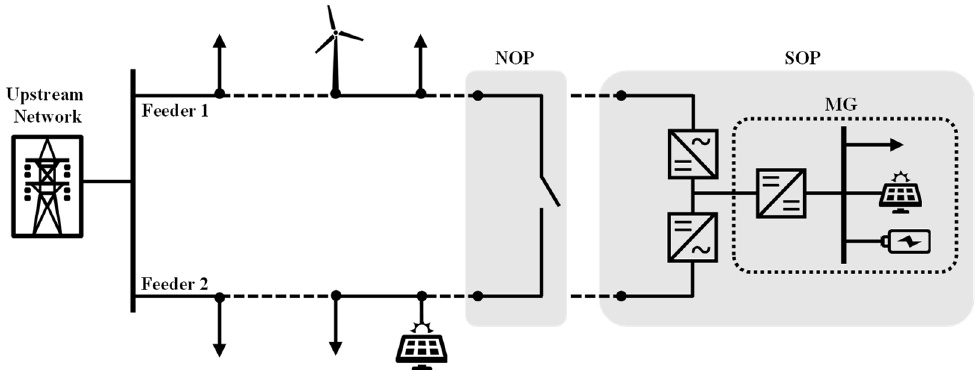
Figure 3. Soft open point and DC microgrid integration in the active distribution network.